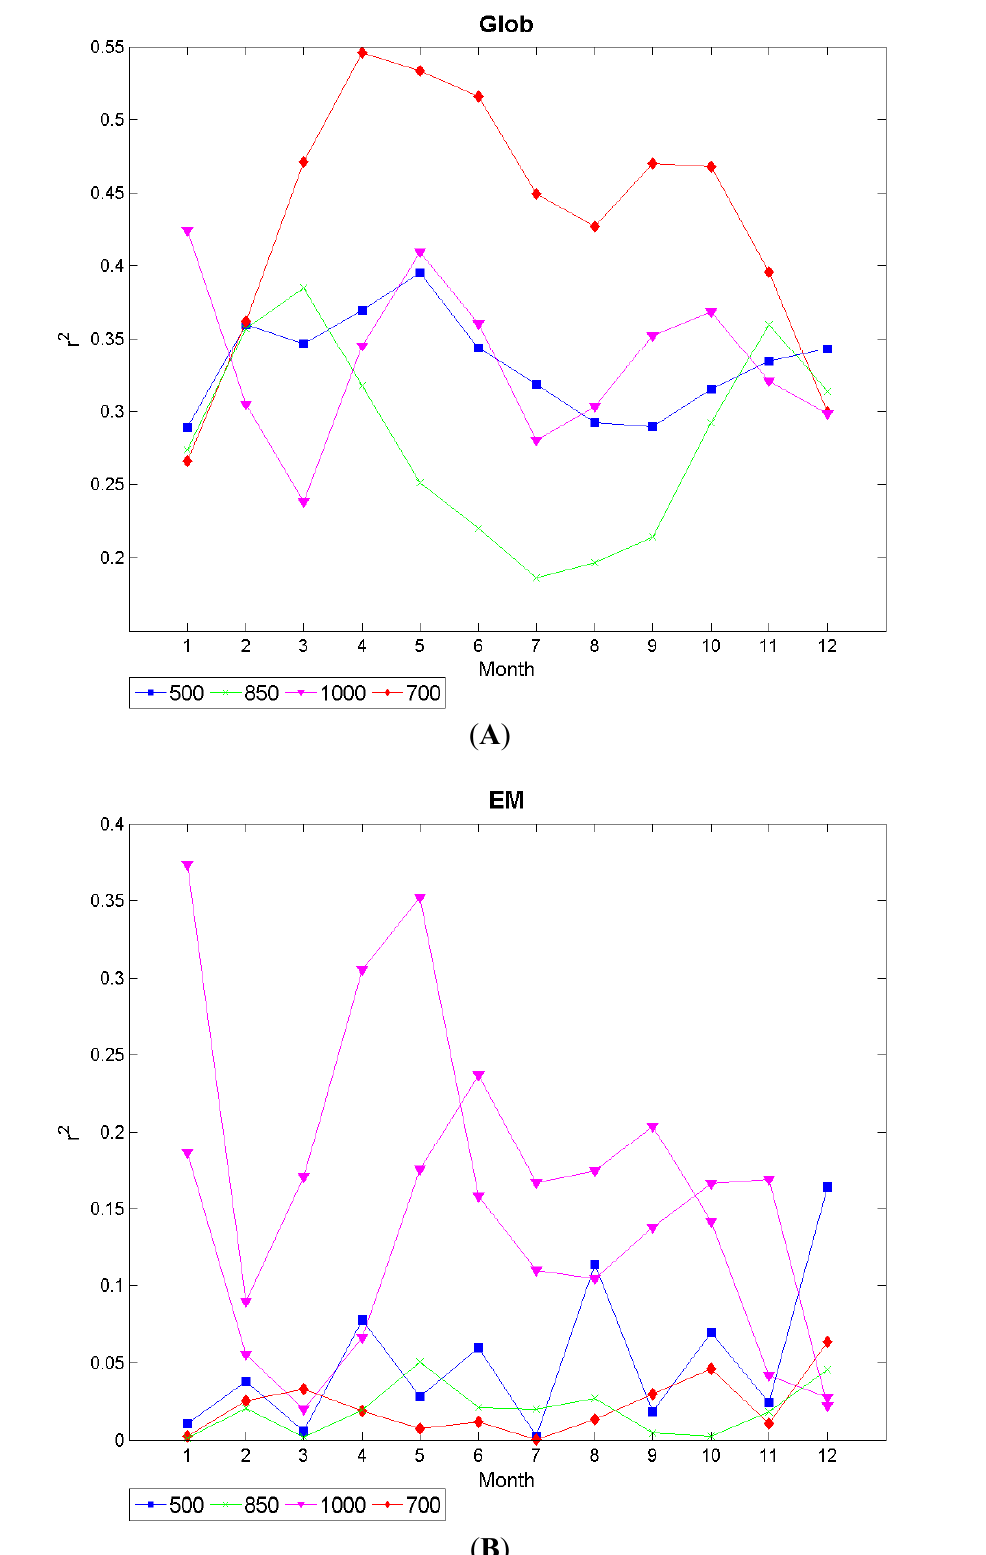
Figure 3. The annual course of the multi-regression R 2 values at the different pressure levels at the full research region ( A , GLOB) and at each subregion ( B – G